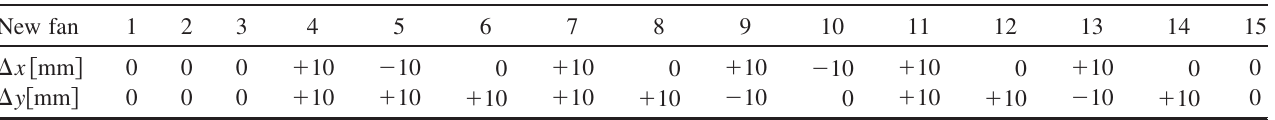
TABLE I. Spatial shifts along the x and the y direction of the vertices of the 15 fans used for the analyses of the sensitivity of the tomographic